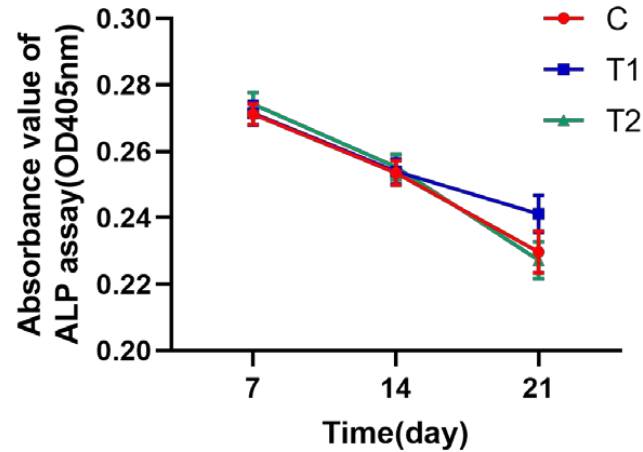
Figure 8. ALP assay results of dental pulp cells in each